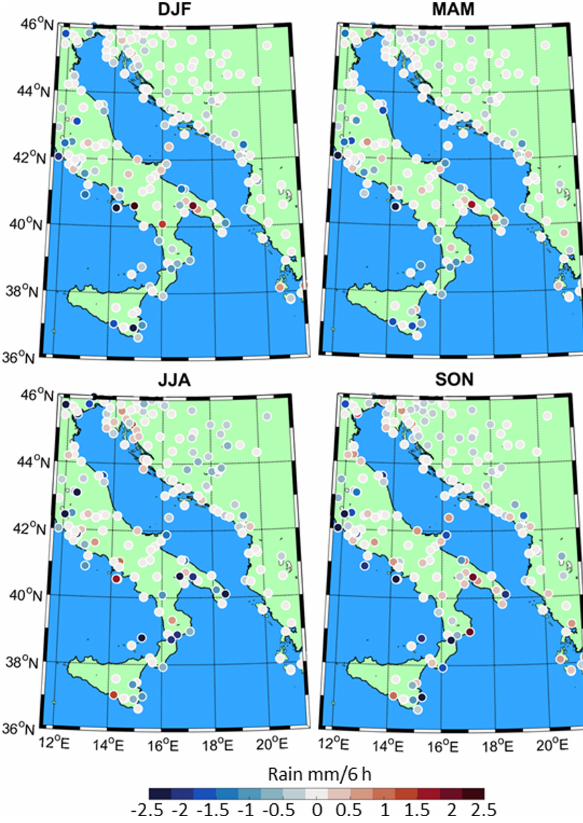
Figure 13. The same as in Fig. 10 but for the hourly pressure